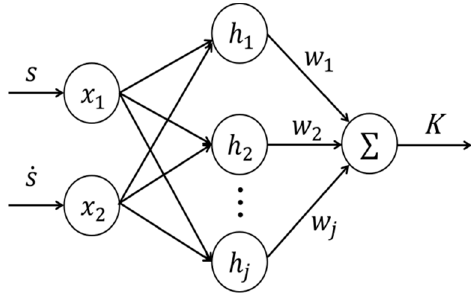
Figure 1. Structure of RBF neural Figure 1 ． Structure of RBF neural network.